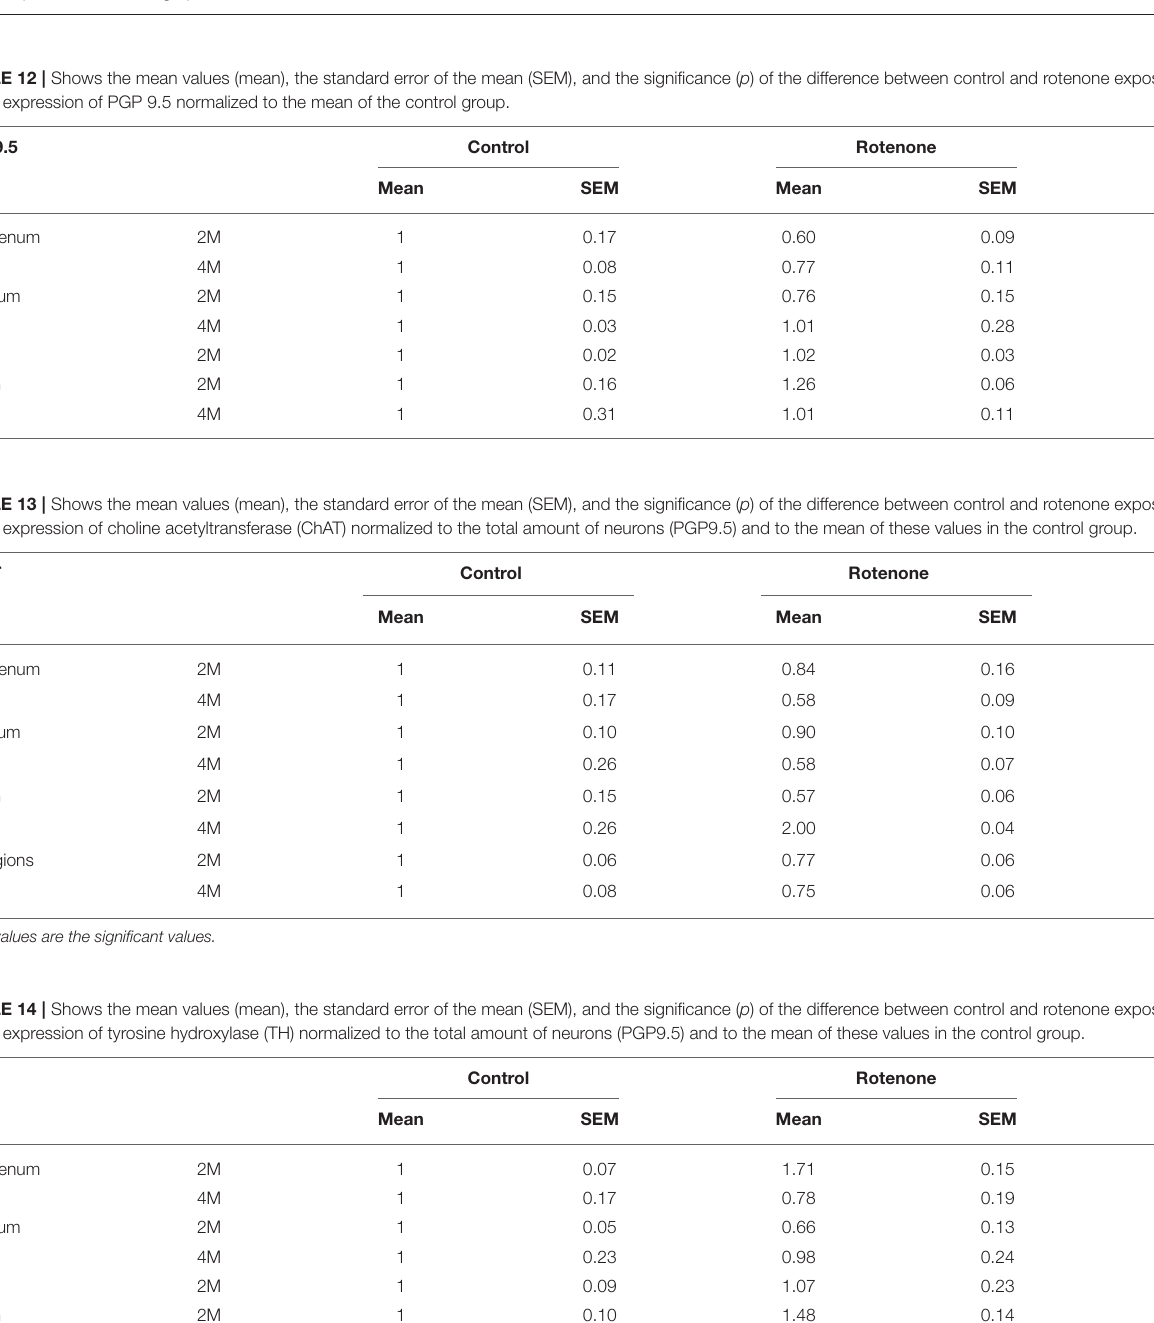
FIGURE 13 | (PGP 9.5) was used as a panneuronal marker to determine the ratio of enteric neuronal population within the sample. Images were quantified using FIJI as described in the material and methods section. ChAT and TH signals were normalized to the total amount of neuronal tissue in the sample by dividing it to the values obtained for PGP9.5 expression. The proportion of enteric neurons was determined by normalizing PGP9.5 signal to the total protein measured with GAPDH. Bar graphs in (B,D,F) show the quantification of the original blots ( n = 5). Data was analyzed using a Student’s t -test. n.s. non-significant (Mann-Whitney Test). Error bars represent SEM in all